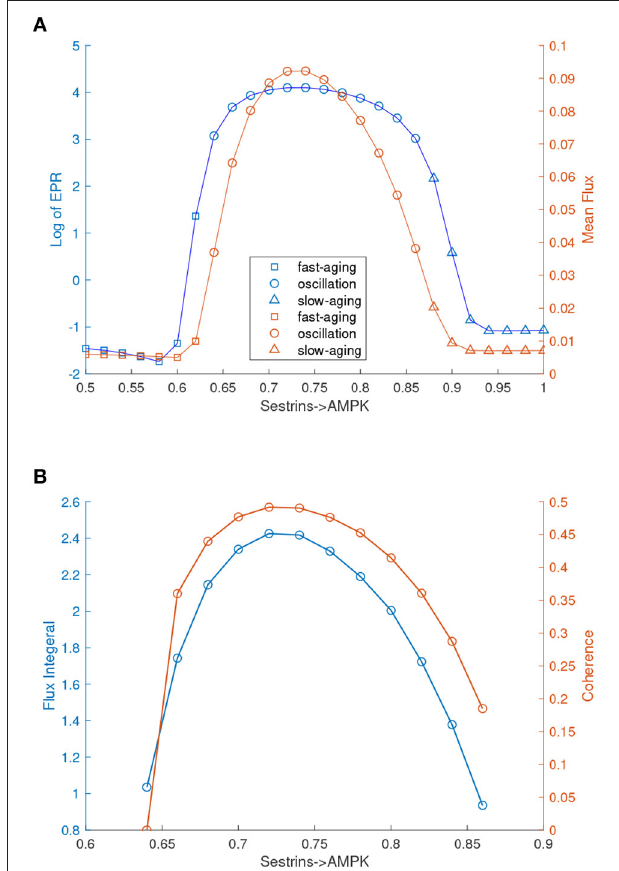
FIGURE 8 | EPR, flux, and coherence changes upon the regulation changes of Sestrins- > AMPK through the transitions from the monostable fast-aging state to the oscillation between the fast-aging state and the slow-aging state, and then to the slow-aging state. (A) The entropy production rate and the mean flux of the monostability and the oscillation. (B) The flux integral and the coherence of oscillations.